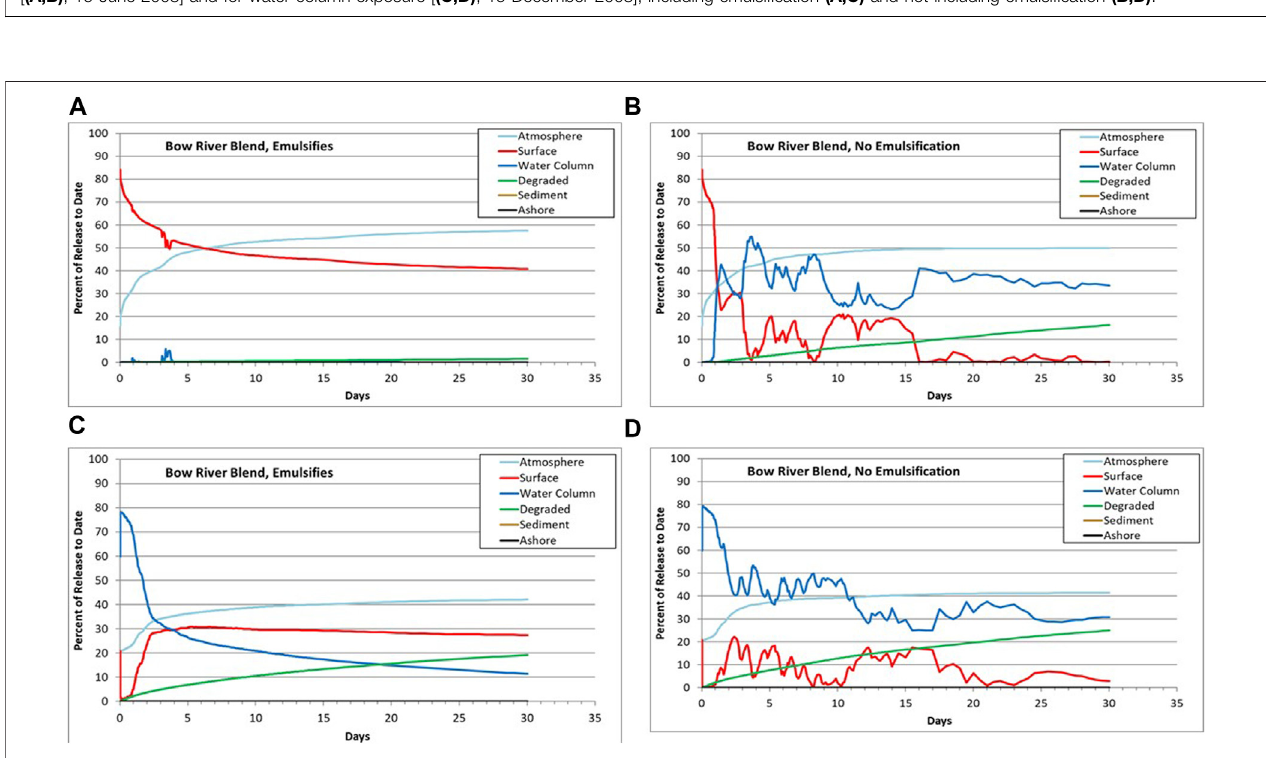
FIGURE7| Massbalance(aspercent ofthespilledmass)forasurfacereleaseof200 MTofBRBfortherunsthatledtothe95thpercentile forsurfaceoilexposure [ (A,B) ; 1 October 2009] and for water column exposure [ (C,D) ; 15 April 2007], including emulsi fi cation (A,C) and not including emulsi fi cation (B,D) .